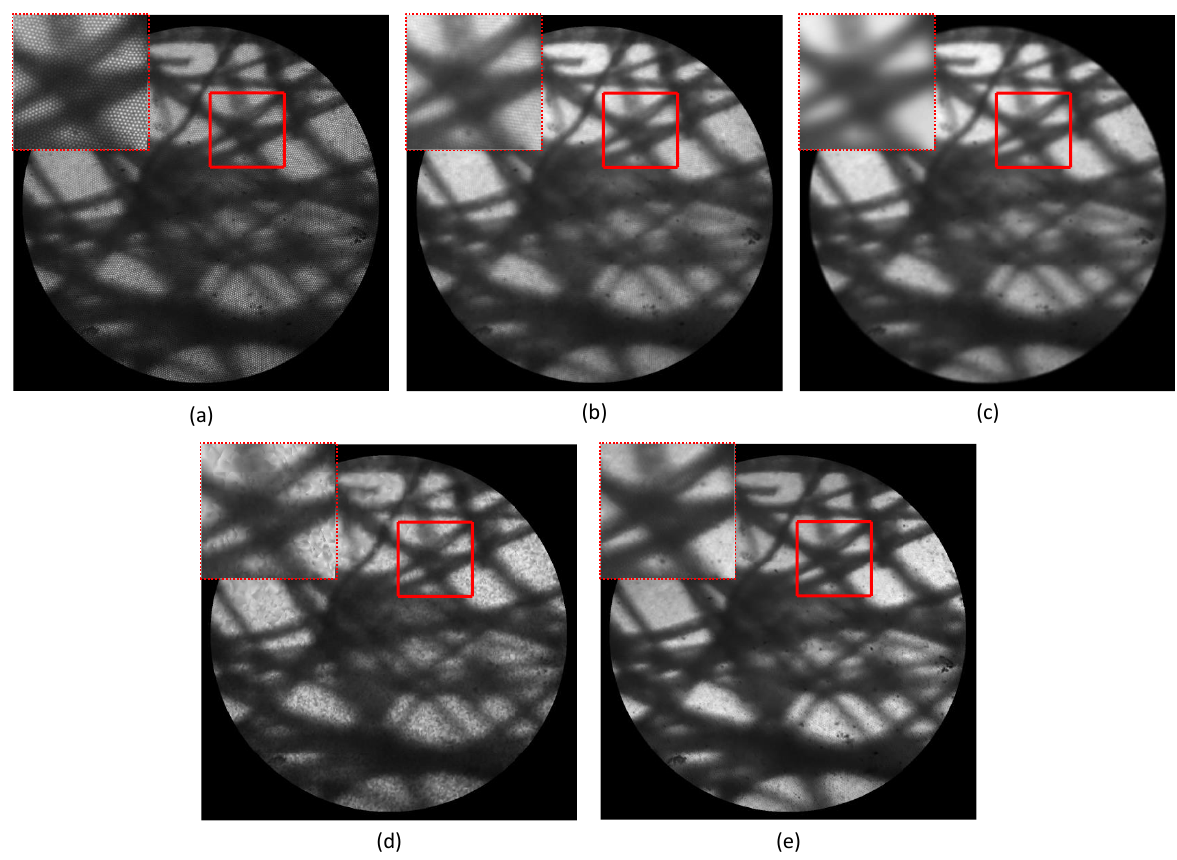
Figure 7. Resulting images for various honeycomb removal methods on the lens tissue sample: ( a ) raw fiber bundle image, ( b ) median filter, ( c ) Gaussian filter, ( d ) interpolation, and ( e ) HAR-CNN (see Video S1). The red-squared region is magnified at the top-left corner of each image to clearly show image restoration details.